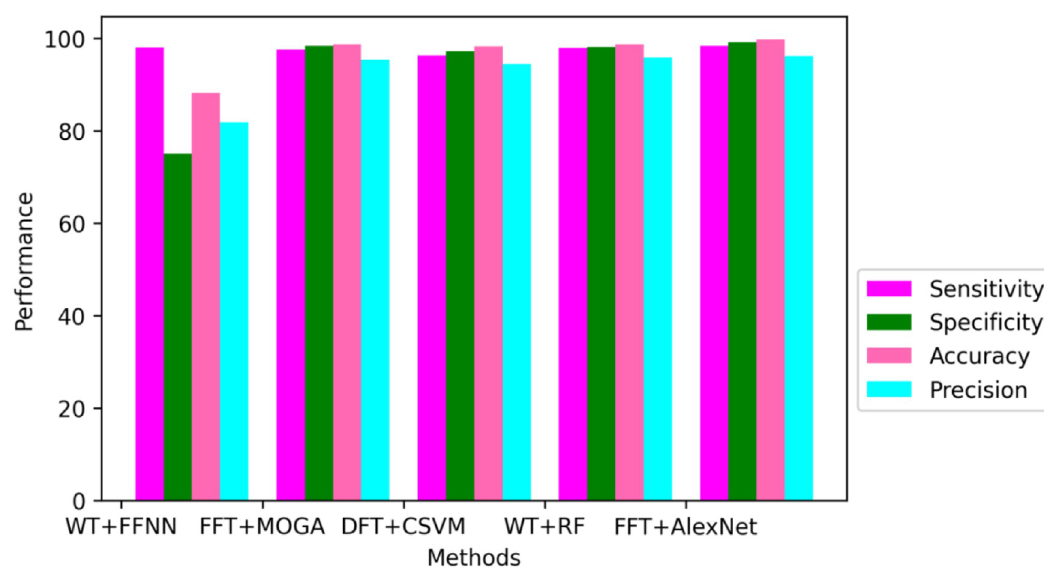
Fig 17. The suggested model is compared to other ECG categorization algorithms.